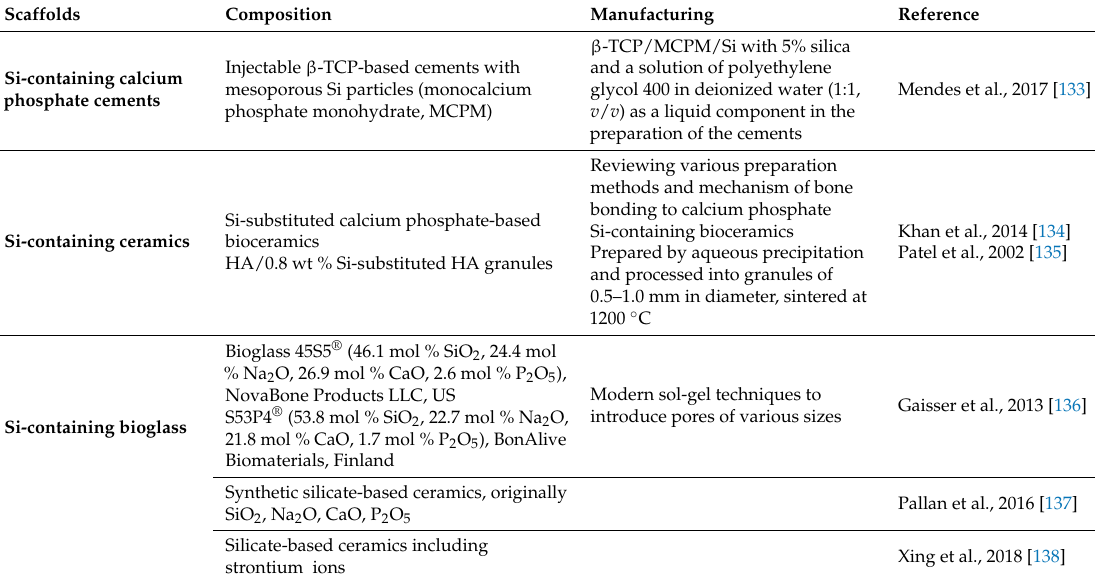
Table 1. Manufacturing methods of Si-containing bone scaffolds. TCP: Tricalcium phosphate; MCPM: Monocalcium phosphate monohydrate; HA: Hydroxy